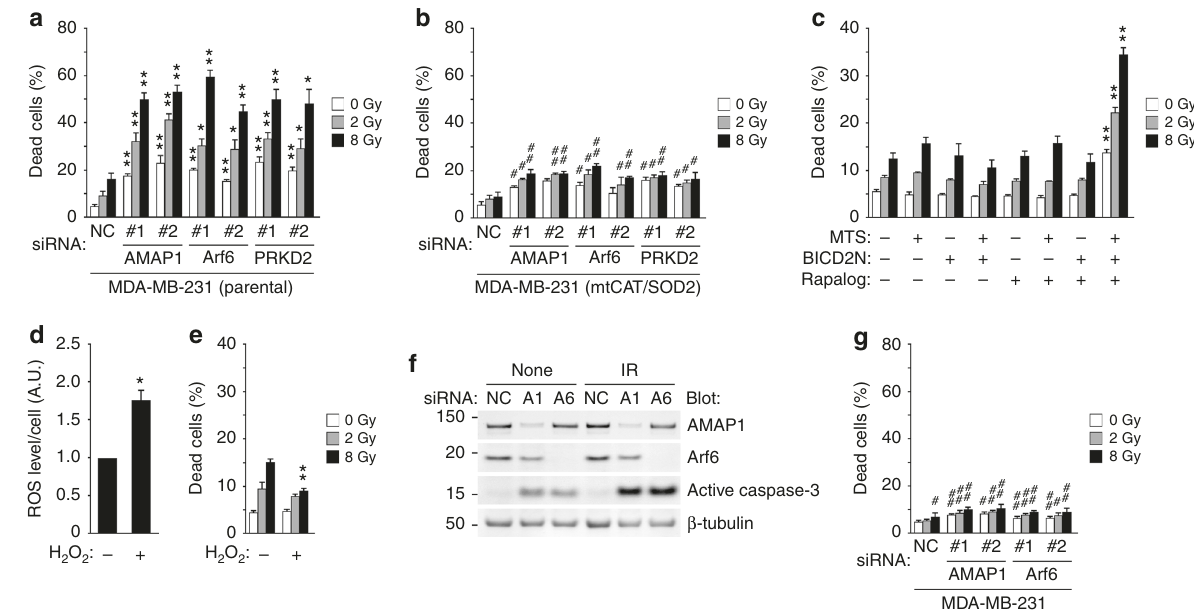
Fig. 3 Mitochondrial aggregation enhances IR-induced cell death via ampli fi cation of ROS. a – c Cumulative cell death after irradiation of MDA-MB-231 cells: parental cells treated with siRNA targeting AMAP1, Arf6, or PRKD2 ( a ), cells stably transfected with mtCAT and SOD2 followed by the indicated siRNAs ( b ), and cells stably transfected with FKBP-MTS (MTS) and/or BICD2N-FRB* (BICD2N) followed by Rapalog treatment ( c ). d , e Quanti fi cation of DHE fl uorescence before irradiation ( d ), and cumulative cell death after irradiation ( e ), in the presence or absence of 50 nM H 2 O 2 . f Activation of caspase-3 in MDA-MB-231 cells treated with the indicated siRNAs examined by western blot. g Cumulative cell death after irradiation of MDA-MB-231 cells with siRNA targeting AMAP1 or Arf6, in the presence of 50 μ M Z-VAD-FMK. All graphs indicate the mean ± SEM of three independent experiments. * and # P < 0.05; ** and ## P < 0.005 (two-tailed t -test, adjusted by the Holm – Sidak method). * and **, comparison to si-NC samples or non-treated cells; # and ## , comparison to the corresponding samples shown in ( a